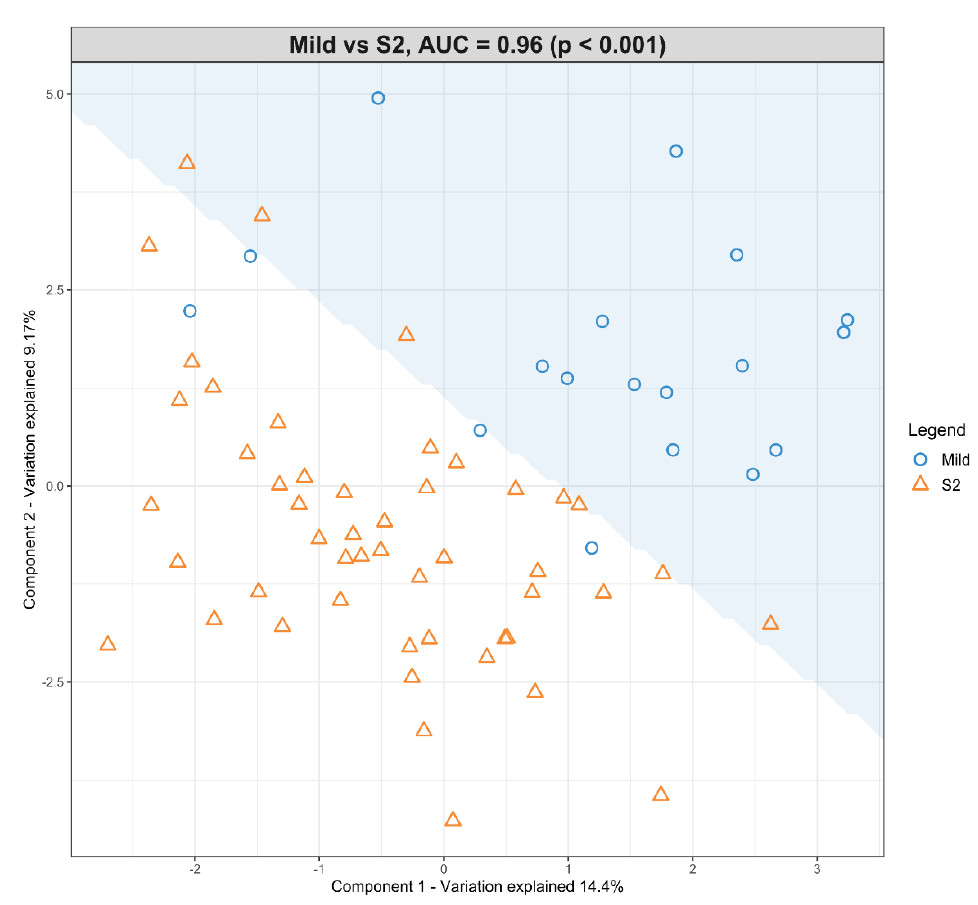
Figure 3. Scatter plot showing the sPLS-DA model and its prediction for Mild cases and Moderate– severe cases at S2. The x axis represents Component 1 and the y axis represents Component 2. Table 5. sPLS-DA loading values for Mild HIE newborns vs. Moderate–severe HIE newborns at S2. Lipid Species Component 1 Component 2 Component 3